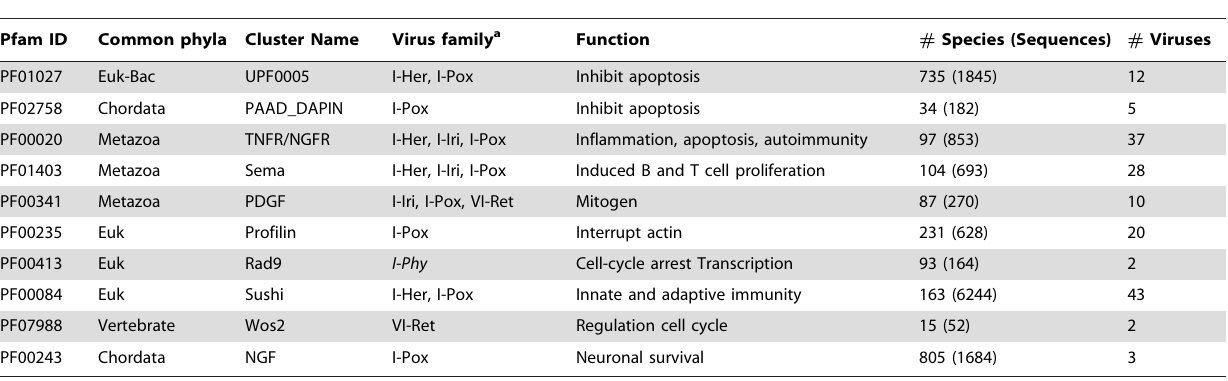
Table 2. A sample of the cross-taxa Pfam families of viruses and metazoa.